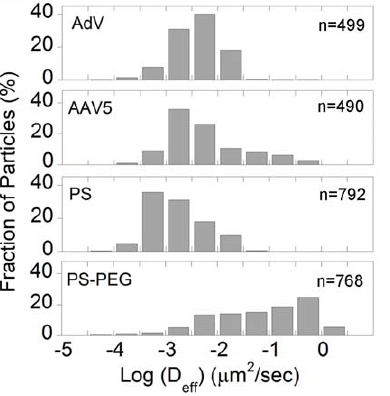
Figure 3. Distribution of logarithms of individual particle effective diffusivities (D eff ). Distributions of D eff of AdV, AAV5, PS and PS-PEG particles represented as a percentage of particles in CF sputum at a time scale of 1 s.